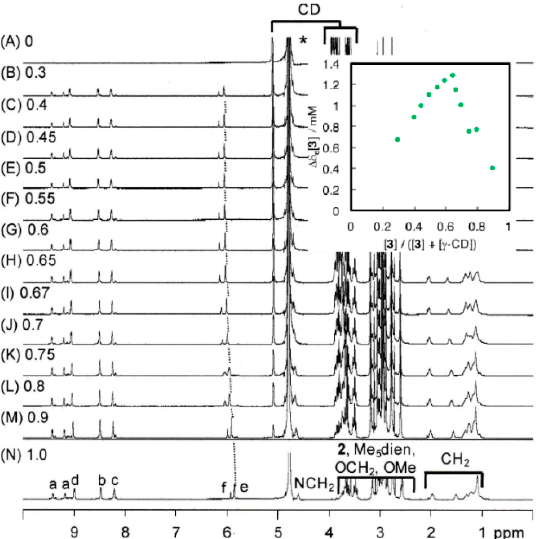
Figure 2. 1 H-NMR spectra of mixtures of [ 3 ] 3+ and γ -cyclodextrin. (D 2 O, r.t., 500 MHz). [ 3 ]/([ 3 ] + [ γ -